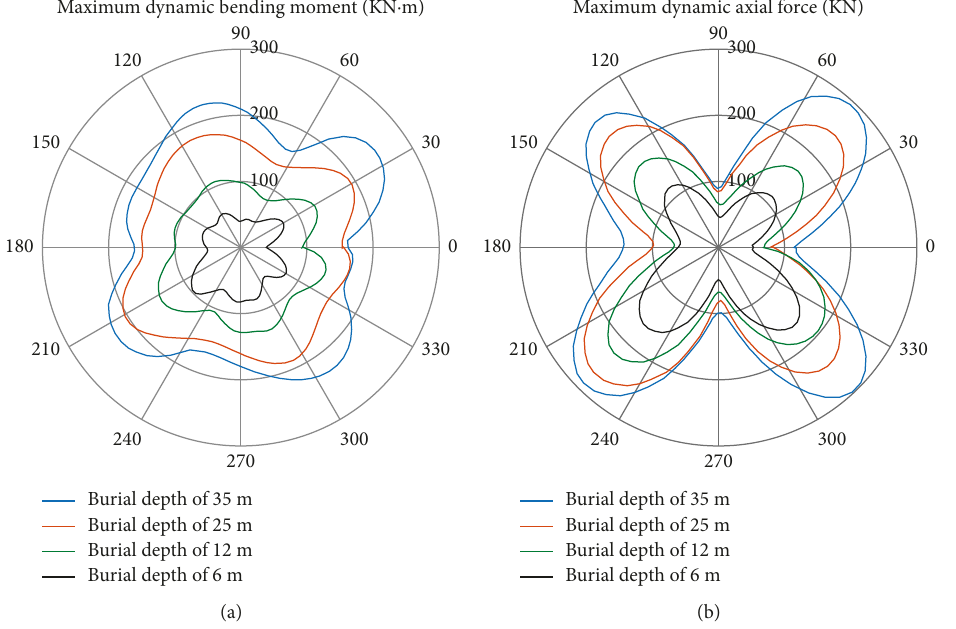
Figure 5: (a) Maximum dynamic bending moment of lining at different positions under different embedded depths. (b) Maximum dynamic axial force of lining at different positions under different embedded